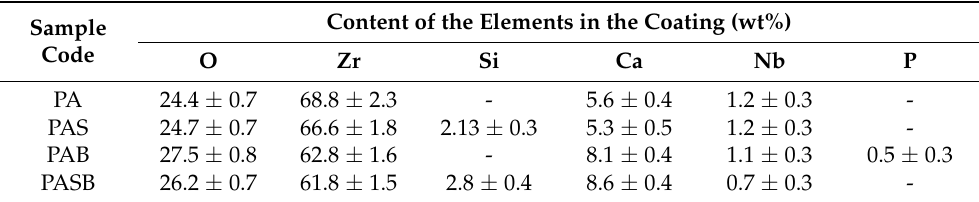
Table 4. The elemental composition of samples PA, PAS, PAB, and PASB obtained by